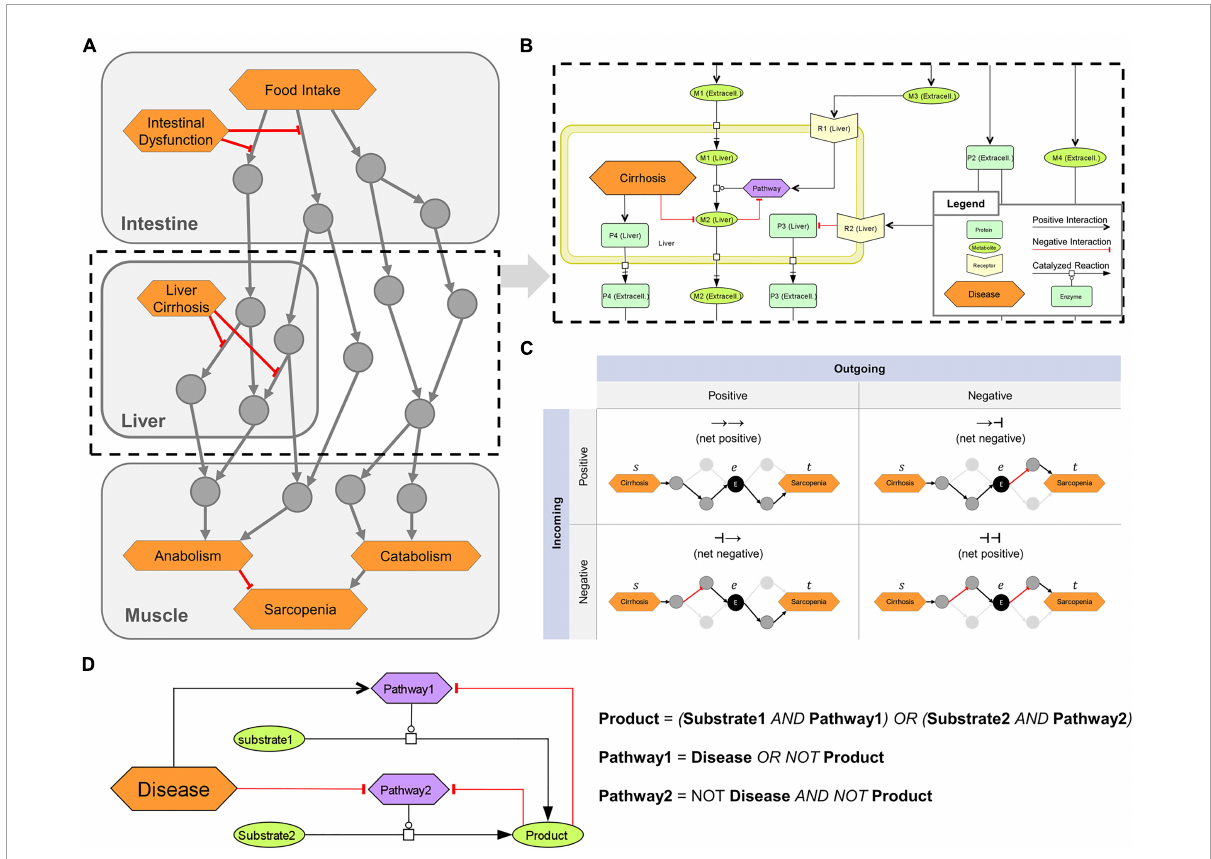
FIGURE1 Overview of the logical modeling approaches in the sarcopenia map. (A) Schematic structure of the Sarcopenia Map. (B) SBML schema of tissue-specific compartments (yellow frames) that are connected through extracellular elements, e.g., representing hormones or cytokines. (C) Topological analysis of the underlying network. Paths between two elements are analyzed based on their length, type (positive or negative), and passed nodes. Elements are ranked by their inclusions in the identified paths. (D) Creation of Boolean rules that define an element’s state by converting SBML reactions into logical